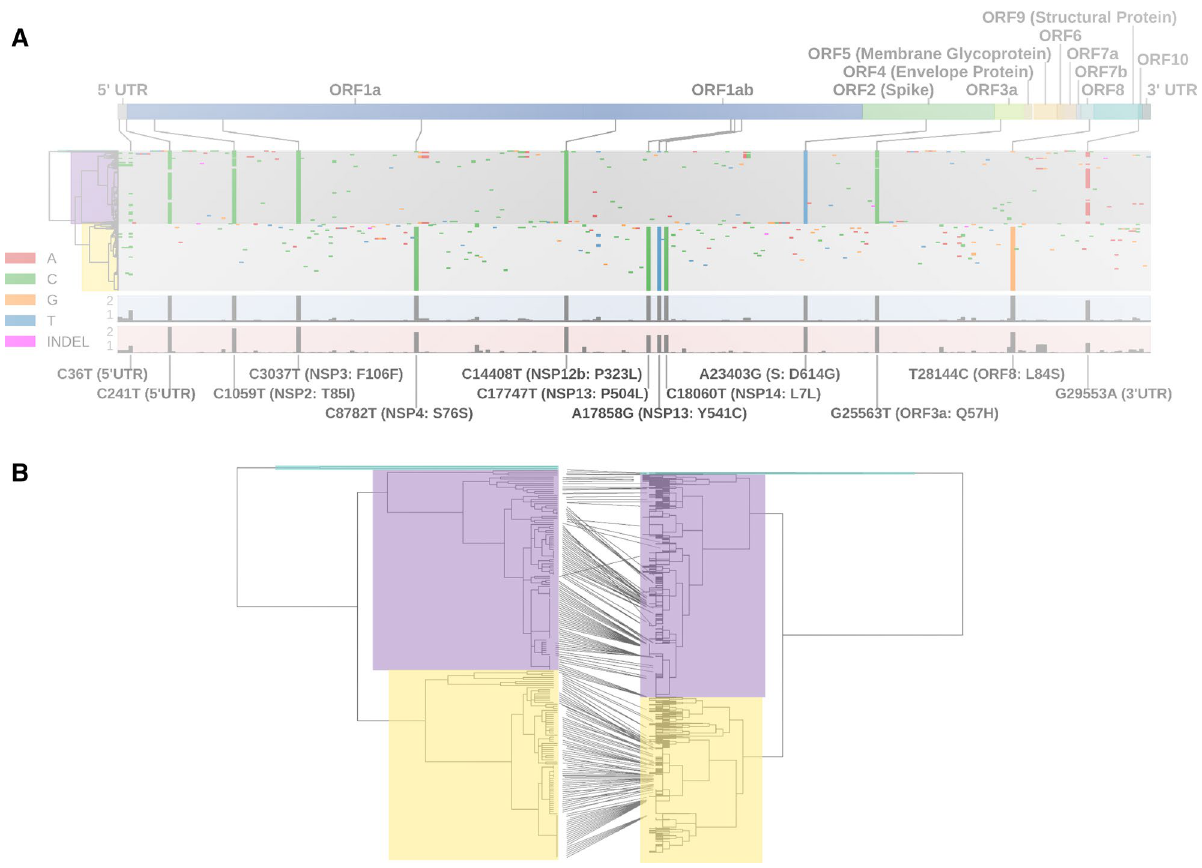
Figure 1. Top—SARS-CoV-2 sequence variants among 190 full length genomes sequenced from outbreak in Seattle, WA March–April 2020 Purple = Clade 1, Gold = Clade 2. Bottom: dendrogram of sequence relations, mapped to identical analysis of 2753 full length sequences in NCBI database.